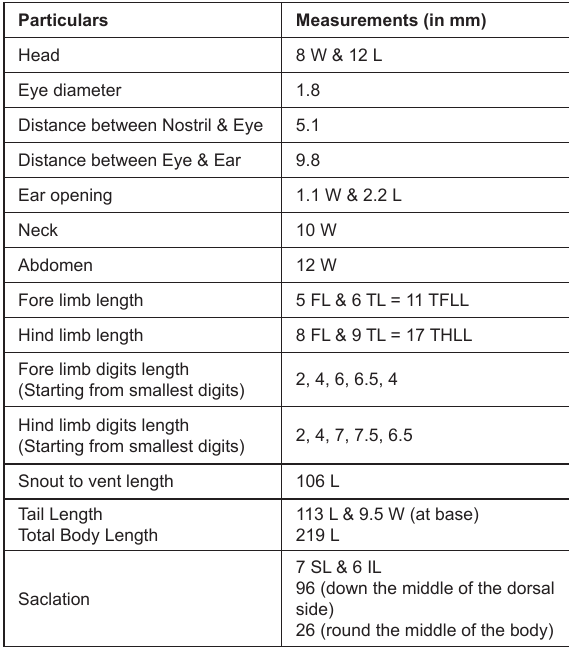
W - Width; L - Length; FL - Femur length; TL - Tibia length; TFLL - Total fore limb length; THLL - Total hind limb length; SL - Supralabials & IL - Infralabials. All measurements were taken by standard vernier